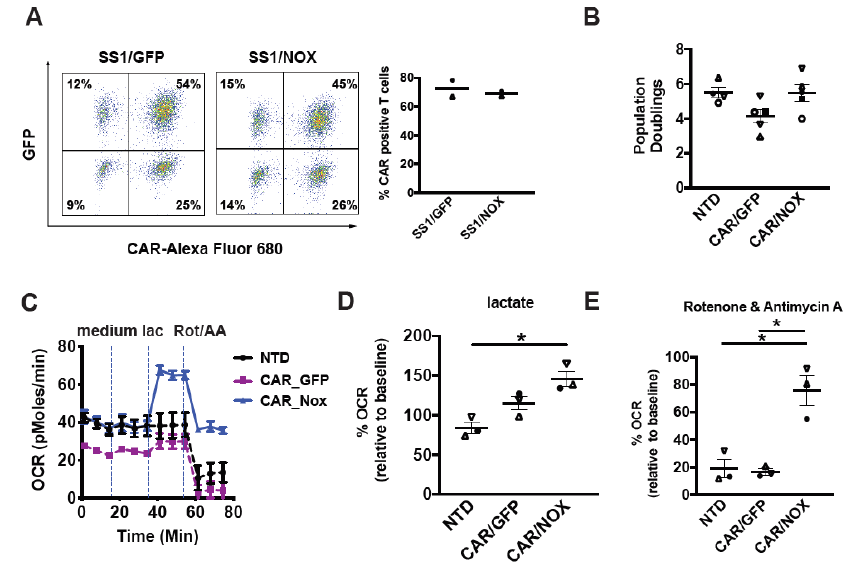
Figure 3. Lactobacillus brevis NADH Oxidase ( LbNOX )-expressing CAR T-cells maintain high rates of oxygen consumption despite electron transport chain (ETC) inhibition . ( A ) After overnight stimulation with Dynabeads, T-cells were co-infected with a mesothelin-specific (SS1-28z) CAR and LbNOX lentiviral supernatants. These cells were expanded for 7 days. Surface SS1 CAR expression was measured by staining with a biotinylated goat anti-mouse IgG (H + L) followed by streptavidin (SA)-Alexa Fluor 680 labeling. LbNOX levels were simultaneously detected by GFP expression. CAR+ cells were defined as double positive for LbNOX ( Y -axis) and APC ( X -axis). Representative flow plots and mean frequencies ± SEM from two independent experiments with separate donors are shown (left and right panels, respectively). ( B ) After overnight stimulation with Dynabeads, activated T-cells were co-infected with a mesothelin-specific (28z) CAR and LbNOX lentiviral supernatants. Cell enumeration was performed every other day beginning on day 3 until the number of cells in the culture ceased increasing, and the mean cell volume was below 350 fL (day 10). The maximum number of population doublings is plotted with the horizontal bars representing the mean and each symbol representing a separate donor. ( C ) GFP vs. LbNOX -expressing CAR T-cells were expanded for 4 days and then transferred to bicarbonate free XF assay medium containing 10 mM glucose and 2 mM glutamine. Metabolic parameters were measured with a Seahorse assay. Cellular oxygen consumption rates (OCR) were measured at baseline, and following the serial addition of XF assay medium, 20 mM lactate and 500 nM rotenone/antimycin A. Representative data from 3 independent experiments with separate donors are shown. Values are means ± S.E.M from 6–8 replicates per assay. ( D ) OCR levels following lactate treatment are expressed as a percentage of baseline OCR. These are plotted with the horizontal bars representing the mean and each symbol representing a separate donor ( n = 3). * p < 0.05 for CAR/NOX vs. NTD. ( E ) OCR levels following rotenone and antimycin A treatment are expressed as a percentage of baseline OCR ( n = 3). * p < 0.05 for CAR/NOX versus NTD; * p < 0.05 for CAR/NOX vs. CAR/GFP. All data were analyzed by a one-way ANOVA using a Holm – Sidak multiple comparison post hoc test.